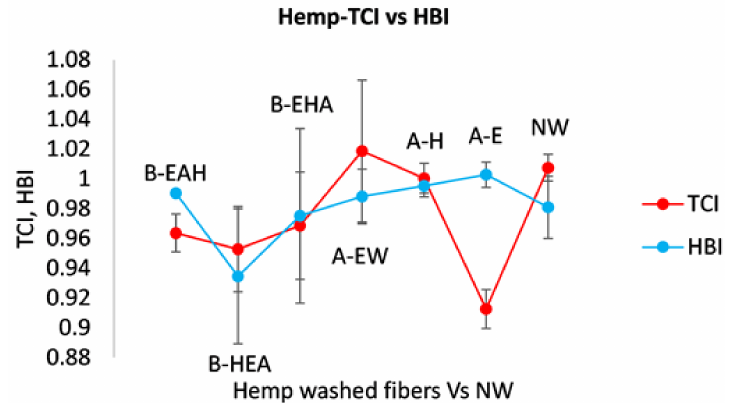
Figure 6. Crystallinity indexes (TCI vs. HBI) of hemp fibers with standard deviations.